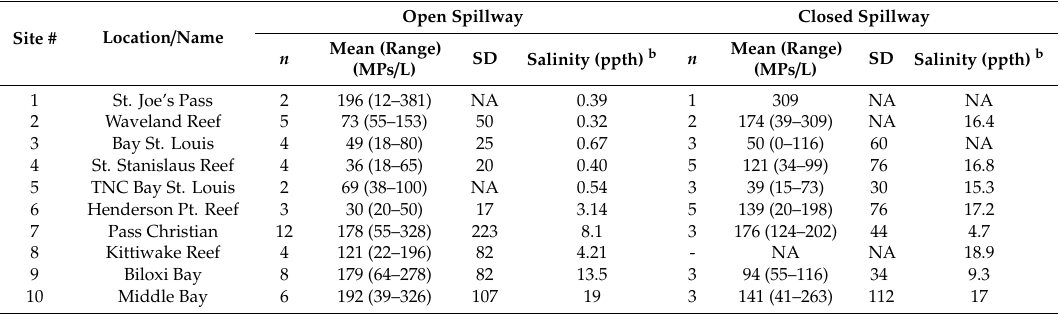
Table 2. Concentrations of microplastics (MPs, > ~25 µ m–5 mm) along the Mississippi Gulf Coast during freshwater inflows in the summer and fall of 2019 and winter of 2020 a